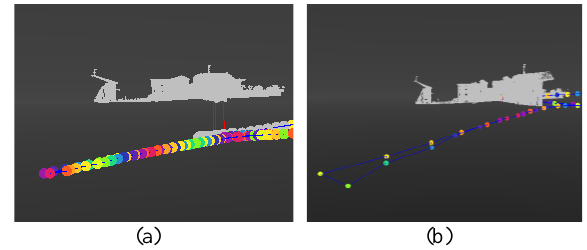
Figure 8. One of the five GCSs (grey-coloured) is introduced inside the Global Optimisation step. Comparison between the trajectory (a) before the optimisation of the cluster and (b) after the optimisation. Red segments indicate the matches error between Local Maps and GCS.